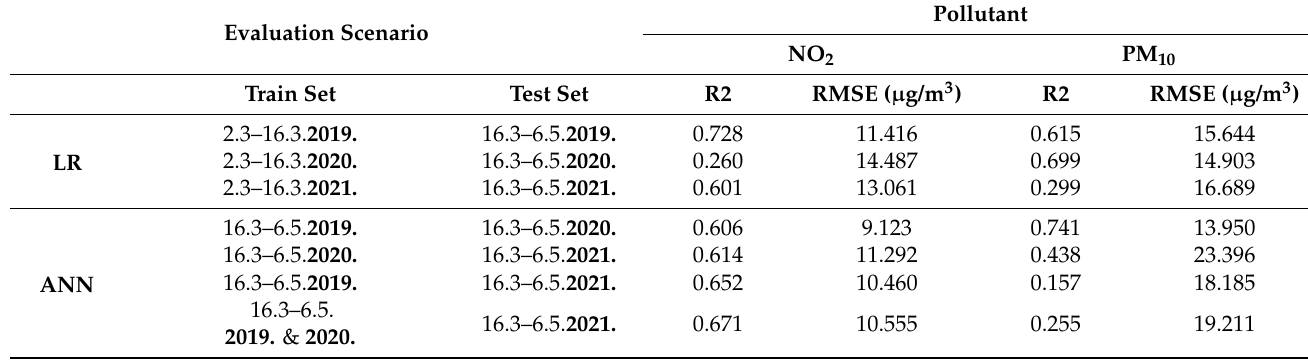
Table 2. Evaluation metrics for different train/test scenarios.